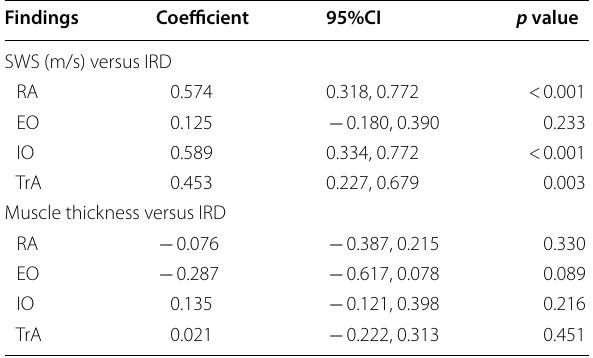
US ultrasound, SWS shear wave speed, IRD inter-rectus distance, RA rectus abdominis, EO external oblique, IO internal oblique, TrA transversus abdominis